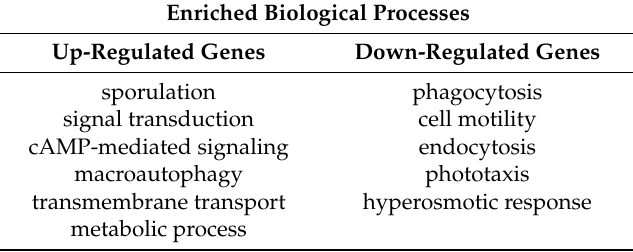
Table 4. Gene ontology (GO) term enrichment analysis of differentially regulated genes in ATG12 − , ATG16 − , and ATG12 − /16 − cells. Selected enriched categories of the biological process for the up- and down-regulated gene sets that were common to all three mutant strains are listed. GO analysis was performed with PANTHER version 11.1 using genes with FC ≥ 2.0 or FC ≤ 0.5 and p -value ≤ 0.05 as input. The full list of enriched categories is provided in Table